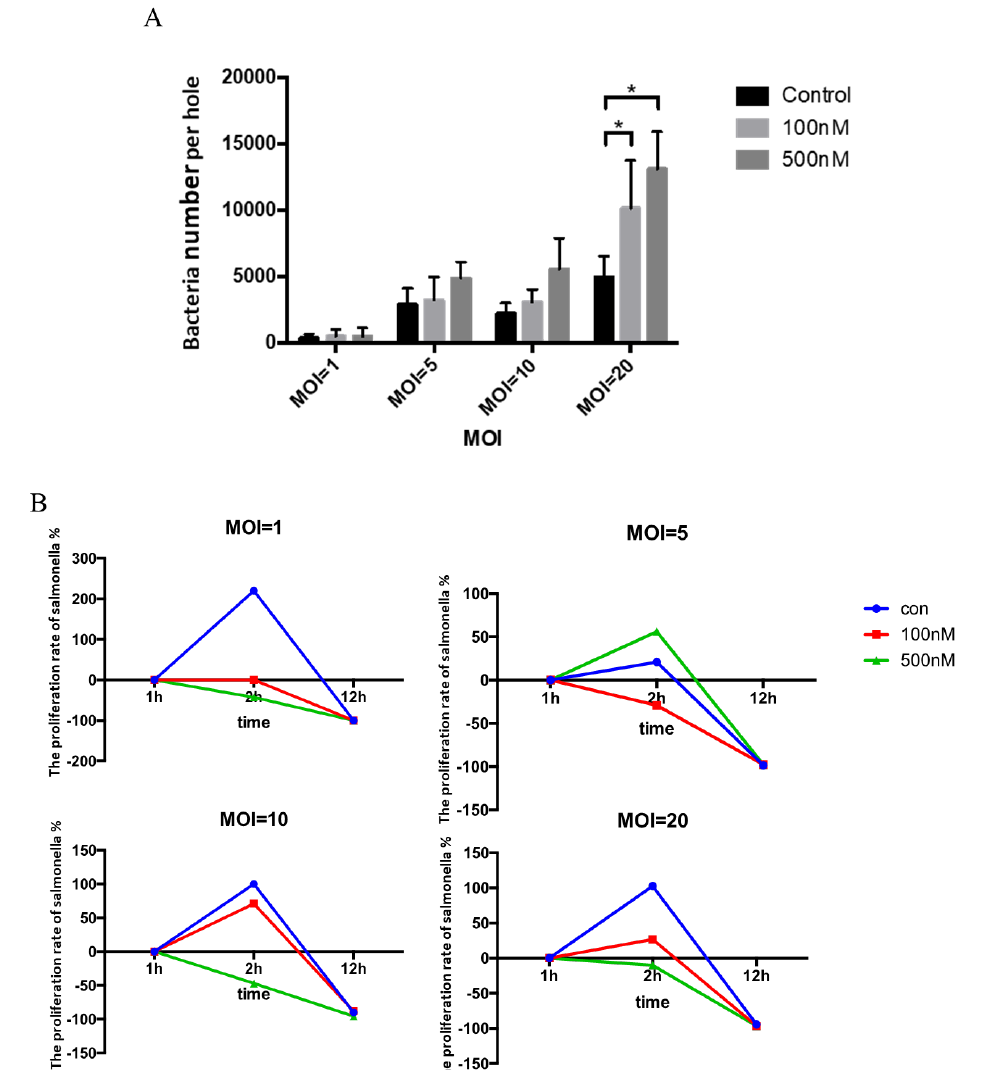
Figure 3. Selenium enhanced the clearance of salmonella within HD11 cells. ( A ) Bacteria number per hole after gentamicin treatment (* indicates a significant difference (p < 0.05). The number of bacteria in HD11 cells pre-treated with different concentrations of Se (sodium selenite) showed an increasing trend at different MOI levels. ( B ) Bacteria clearance rate after 0, 2, and 12 h in Se-stimulated HD11 cells. The proliferation rate of salmonella within DH11 cells treated with 100 and 500 nM of Se was decreased substantially at 2 h post-infection at different MOI levels.